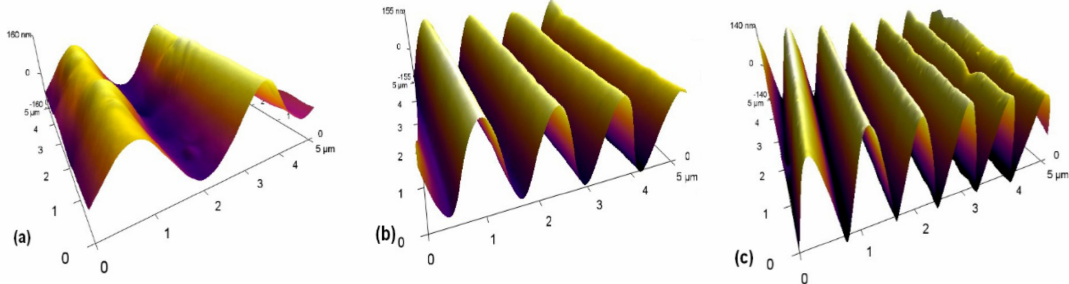
Figure 7. Three-dimensional AFM images of the SRG, inscribed in the thin film sample with NP concentration C = 10% and recording angles ( a ) 2 θ = 10 ◦ , ( b ) 2 θ = 20 ◦ , and ( c ) 2 θ = 30 ◦ .